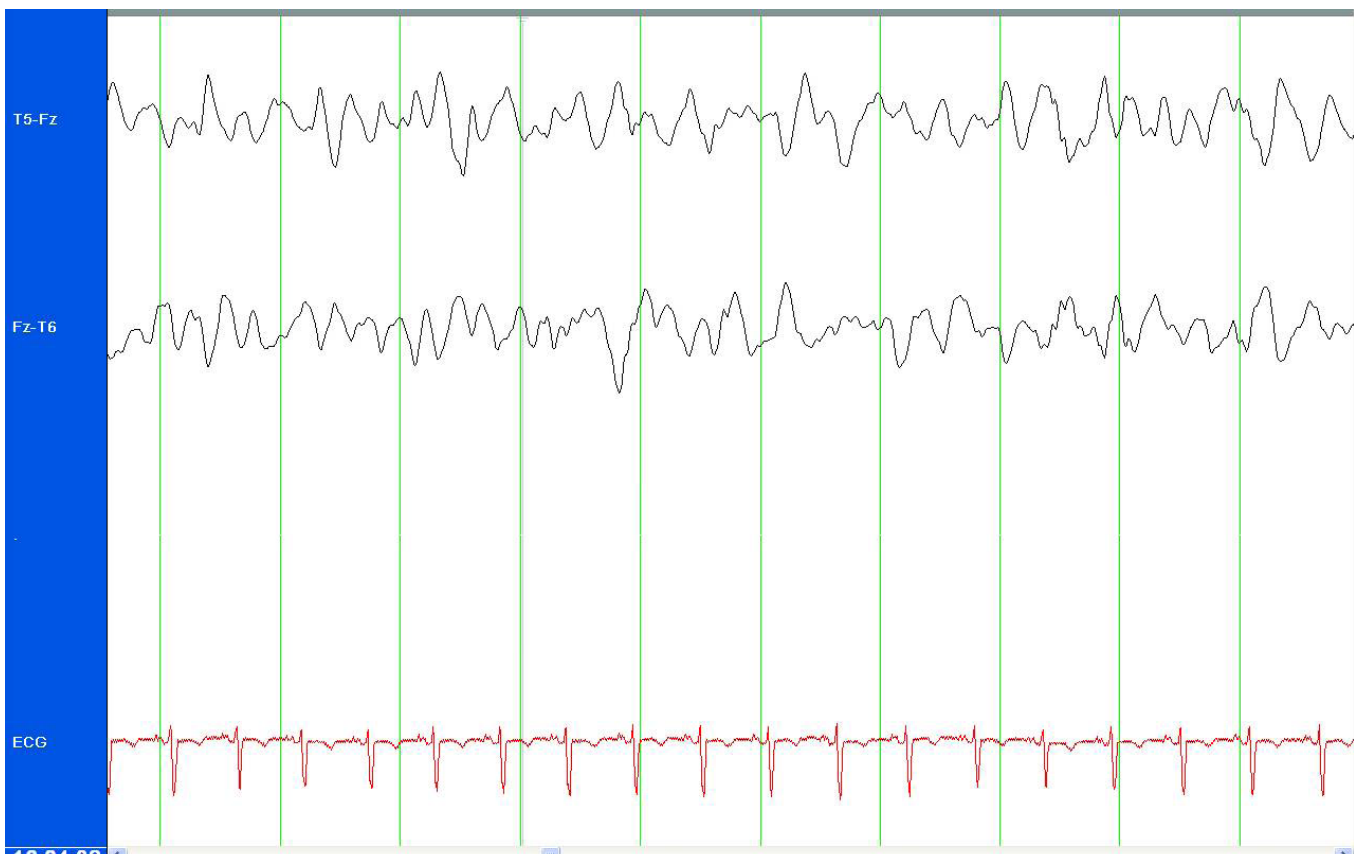
Figure 2 . Tracings from Brainmaster reduced-lead electroencephalogram showing periodic lateralized epileptiform